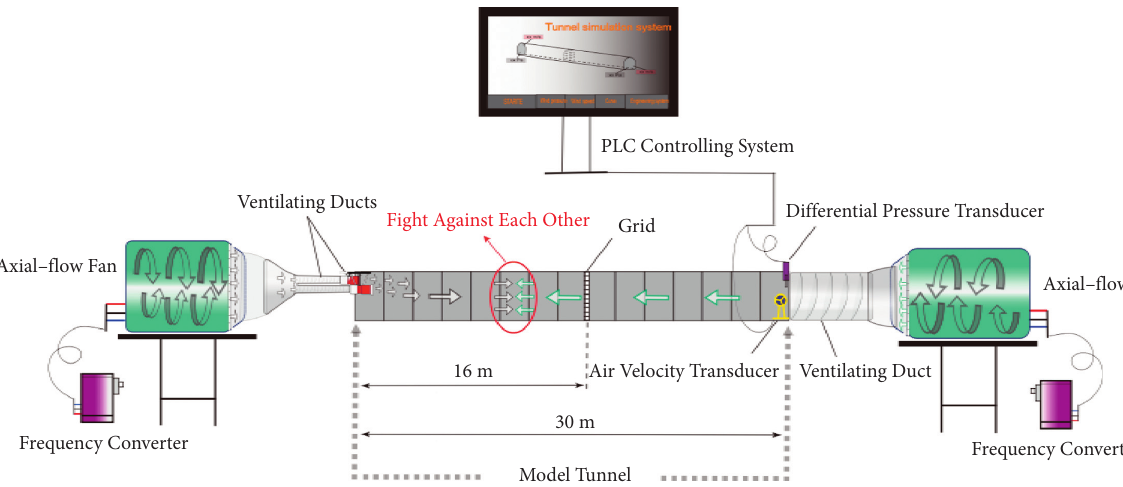
Figure 11: Layout of experimental system.